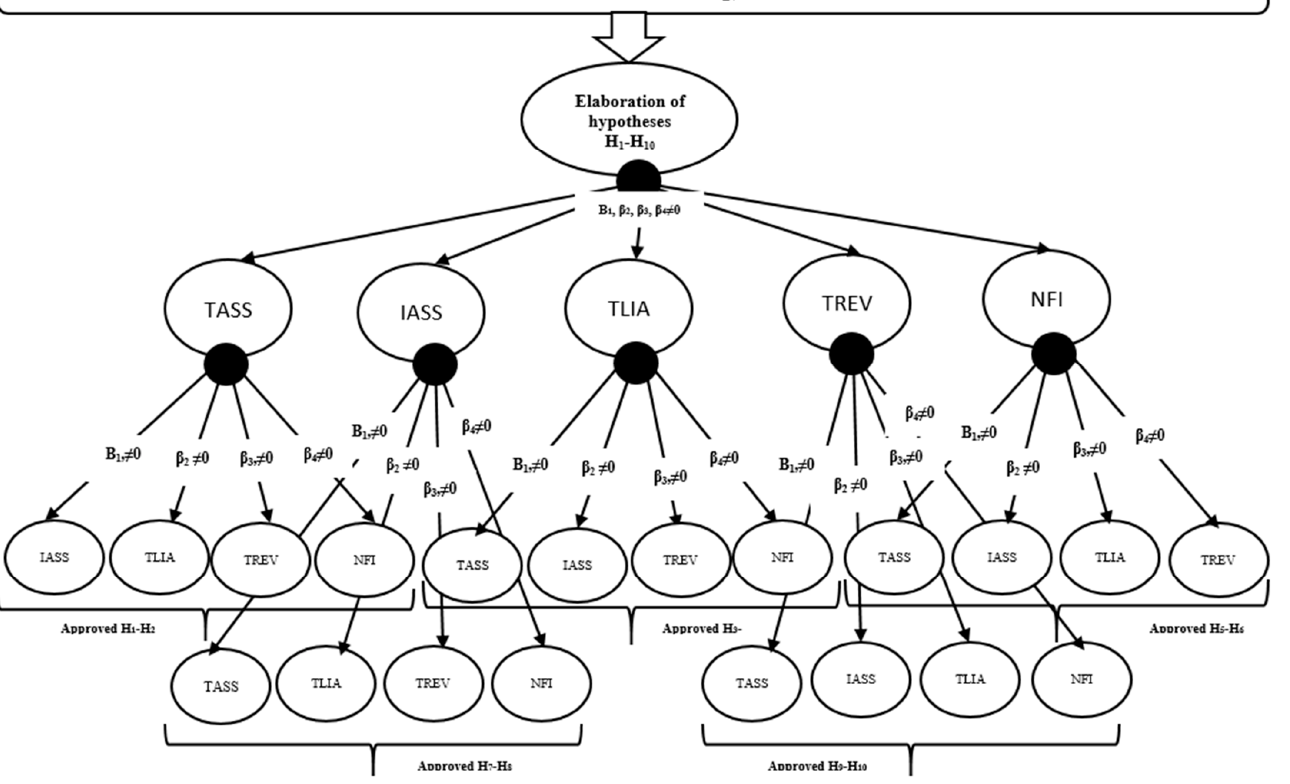
Figure 6. Elaboration of the hypotheses of the IAAFSBCS model. Data processing by the authors.